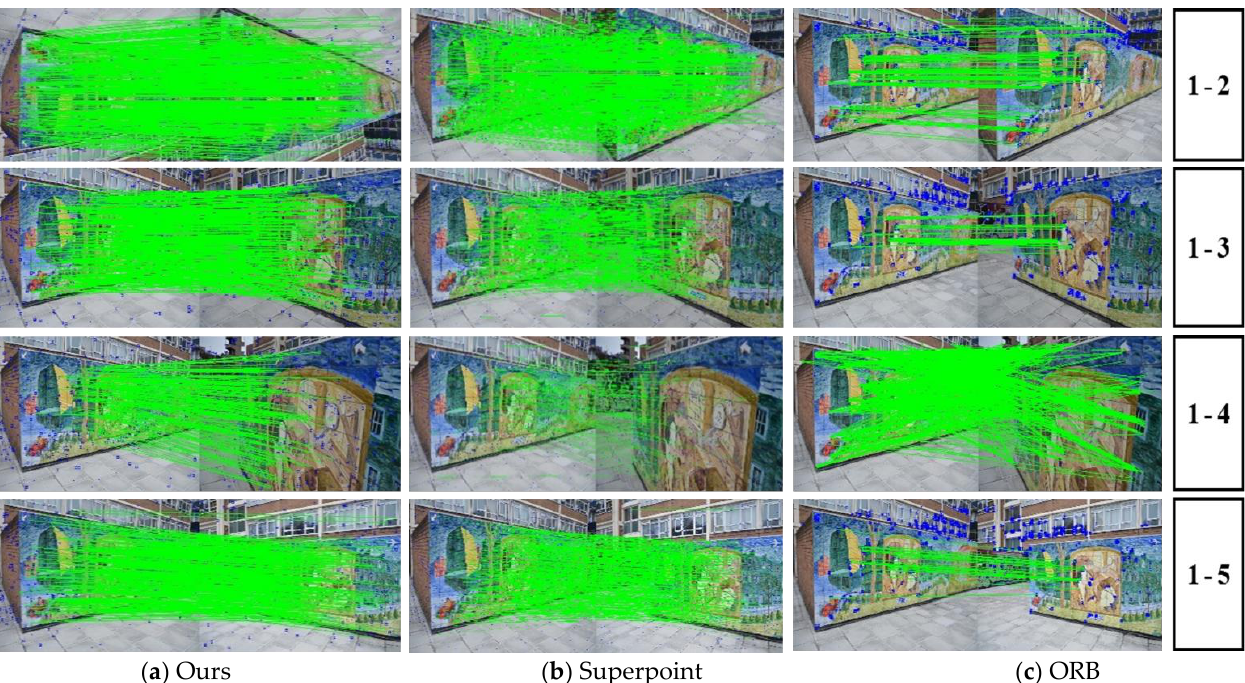
Figure 6. Feature point matching and comparison of viewing angles. Among them, 1- i ( i =2, 3, 4, 5) is the matching between the first and i -th view images.